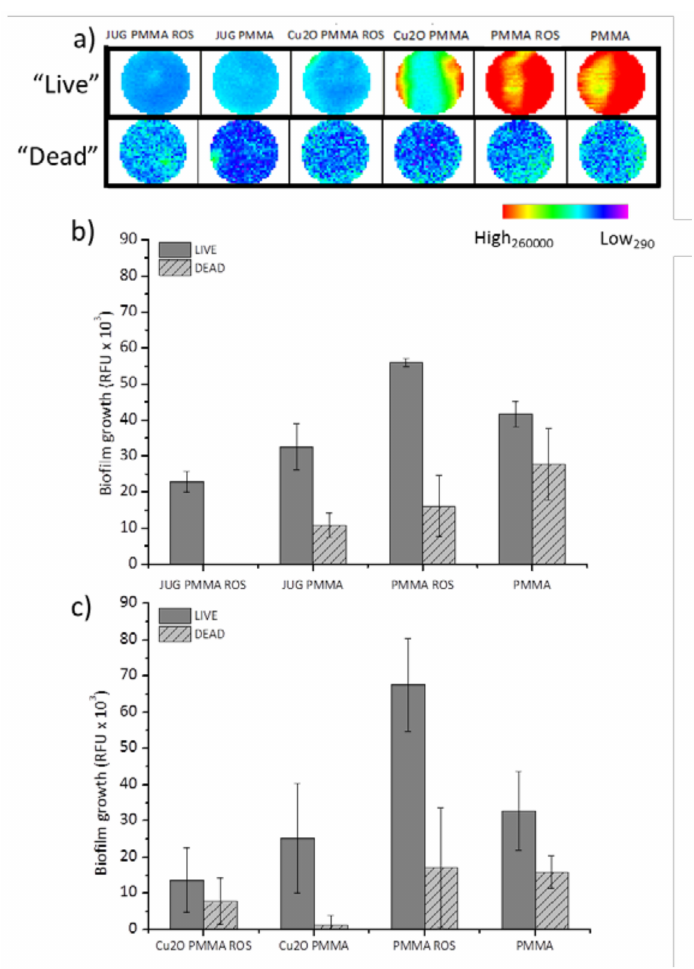
Figure 2. Biofilm growth/adhesion after 48 h using LIVE/DEAD (Syto9/PI) nucleic acid staining on coated coupons: ( a ) representative well-scanning images (213 × 213 µ m scanning matrix) of the in situ fluorescence measurements; ( b ) average fluorescence signals from NP coatings and controls and ( c ) average fluorescence signals from biocidal coatings and controls. JUG = juglone, PMMA = poly(methyl methacrylate), ROS = rosin. RFU: Relative Fluorescence Units, ±